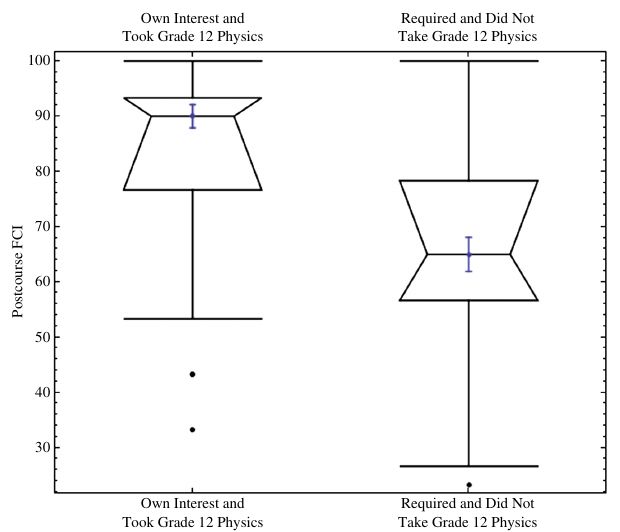
FIG. 7. Two different categories of students and their post- course FCI